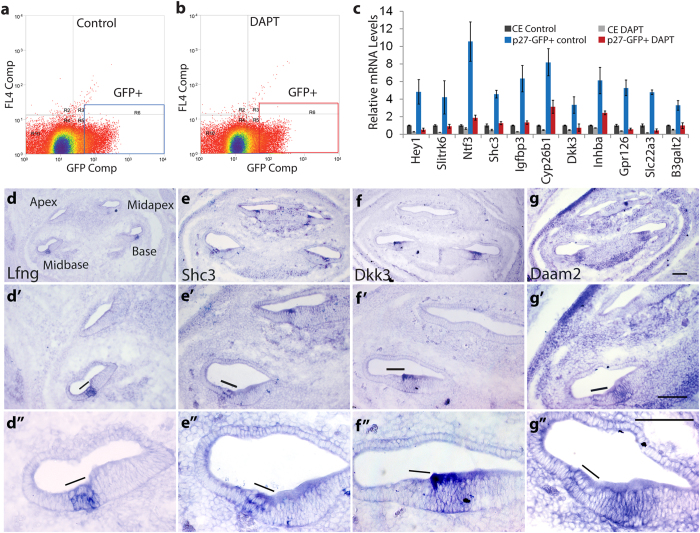
Identification of Notch-regulated genes that are selectively expressed in SCs(a–c) Analysis of Notch-dependent gene expression in purified SCs. (a,b) FACS plots of compensated GFP fluorescence of p27/GFP transgenic cochlear epithelial cells (CE) control (a) and CE DAPT (b) cells. Blue and red box indicate gating for GFP+ SCs. (c) RT-qPCR was used to analyze relative expression of Notch-regulated genes in CE control (black bar), CE DAPT (light grey bar), P27-GFP+ control (blue bar) and p27-GFP+ DAPT (red bar) SCs. Data expressed as mean ± SEM (n = 3, technical replicate). (d–g”) Cochlear expression pattern of newly identified Notch-regulated genes. Low, medium (‘) and high power images (“) of stage E15.5 (d,d’,d”) and E16.5 (e–g”) cochlear sections labeled for Lfng (d,d’,d”) Shc3 (e,e’,e”), Dkk3 (f,f’,f”) and Daam2 (g,g’,g”) transcript. Black line marks sensory domain. Scale bar 100 μm.